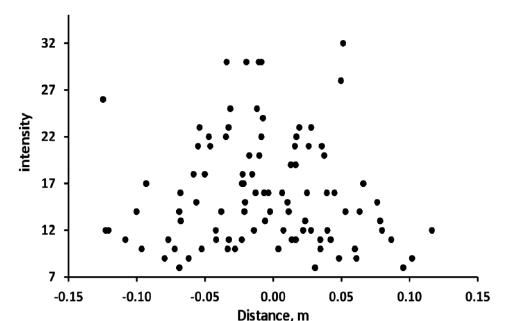
Figure 2. Intensity of LMS-Q680i (dataset 2011b) echoes trig- gered by 40-m-long power line cables. Horizontal axis shows the distance from the cable. The within-pulse irradiance is the- oretically